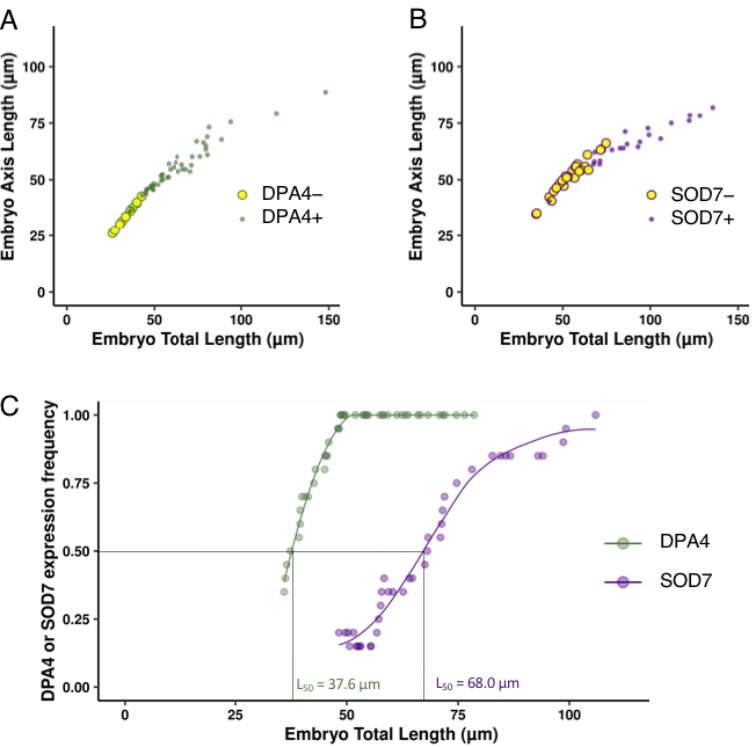
Figure 5. Dynamics of pDPA4:GFP and pSOD7:GFP activation in developing wild-type embryos. ( A ) Wild-type embryos not expressing pDPA4:GFP (large yellow circles with green outline) or expressing it (small green dots) were plotted in a morphospace with embryo total length along the x-axis and embryo axis length along the y-axis. ( B ) Wild-type embryos not expressing pSOD7:GFP (large yellow circles with purple outline) or expressing it (small purple dots) were plotted in a morphospace with embryo total length along the x-axis and embryo axis length along the y-axis. ( C ) Models of pDPA4:GFP (green) and pSOD7:GFP (purple) activation during wild-type. The dots represent the average of the frequency of reporter-expressing embryos calculated on a 20 embryo-wide sliding window. The green and purple lines represent curves fitted on these points. The total embryo length at which half of the embryo expressed pDPA4:GFP or pSOD7:GFP (L 50 ) were calculated (shown with dotted black lines).